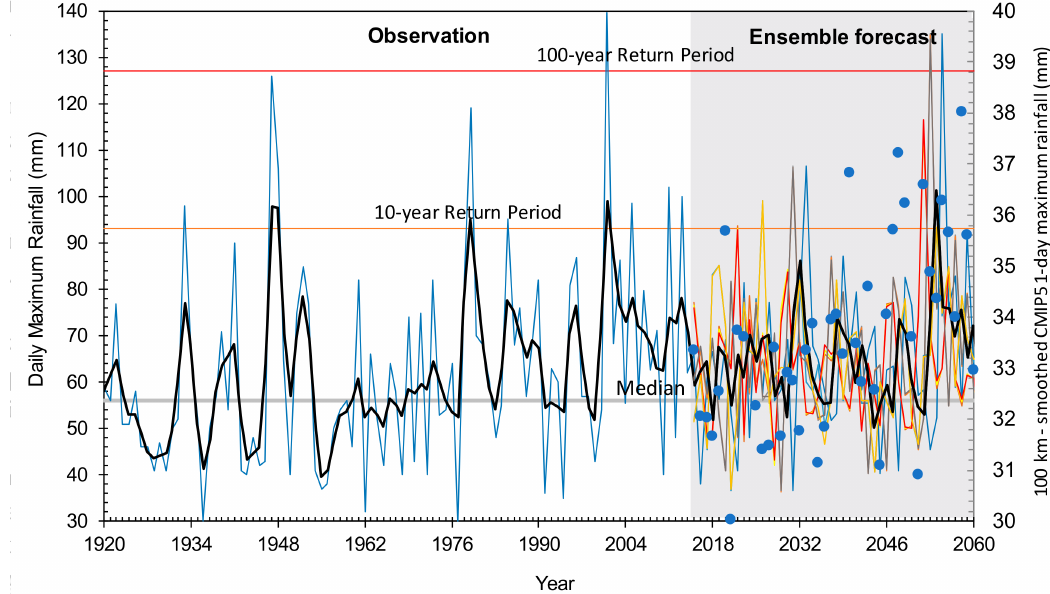
Figure 4. Evolution of daily maximum rainfall (blue curve) for the observed (1920–2016) and forecasted (2017–2066) periods, with its smoothed five-year Gaussian filter and uncertainty plumes extrapolation (bold black and colour curves, respectively). Long-term median value (bold grey line) and 10 and 100-year return periods are also reported (orange and red lines, respectively). Dots in blue are the CMIP5 (Coupled Model Intercomparison Project Phase 5) model mean (rcp8.5) precipitation extremes (one-day maximum) from General Circulation Model (GCM) projections at a horizontal resolution of 100 km, as derived from the ETCCDI (Expert Team on Climate Change Detection and Indices; http://etccdi.pacificclimate.org) extremes indices archive (via Climate Explorer).